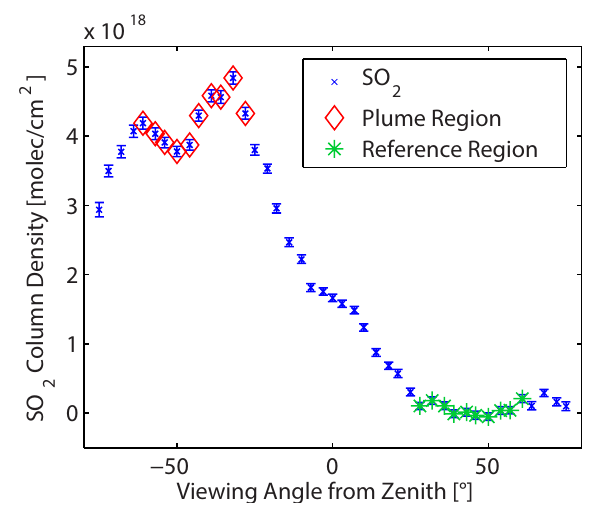
Figure 2. Example of the SO 2 column densities from one complete scan ( − 75 ◦ – zenith – + 75 ◦ elevation angle, measured clockwise when looking towards the volcano). The red diamonds show the col- umn densities defining the volcanic plume region, while the green asterisks show the column densities defining the reference